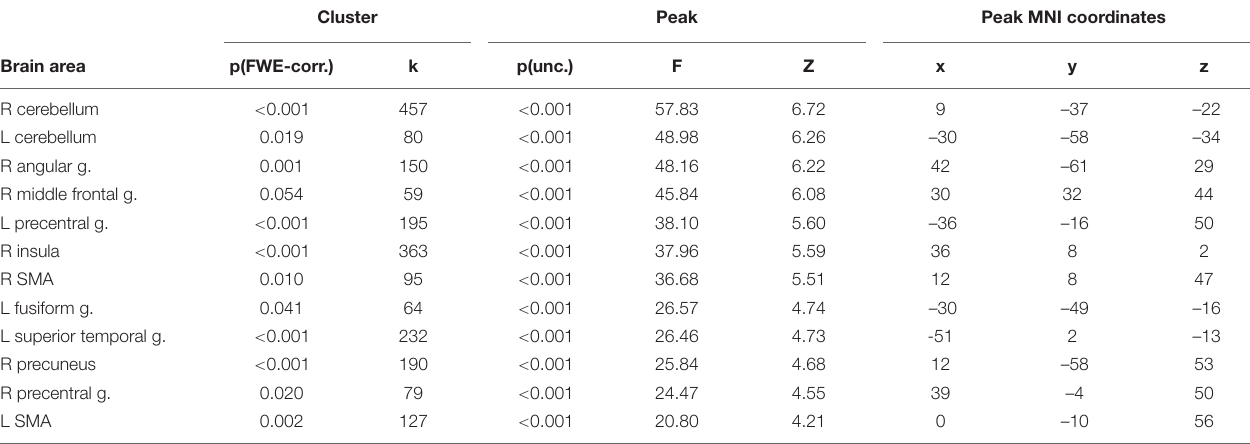
TABLE 7 | Results of the group-level gPPI analysis with the ROI in the right IFG for the interaction between the level of observed provocation and the anonymity of the opponent during the “Feedback” phase (uncorrected p < 0.001 at the voxel level, FWE-corrected at the cluster level p < 0.05, and k = 15). Cluster Peak Brain